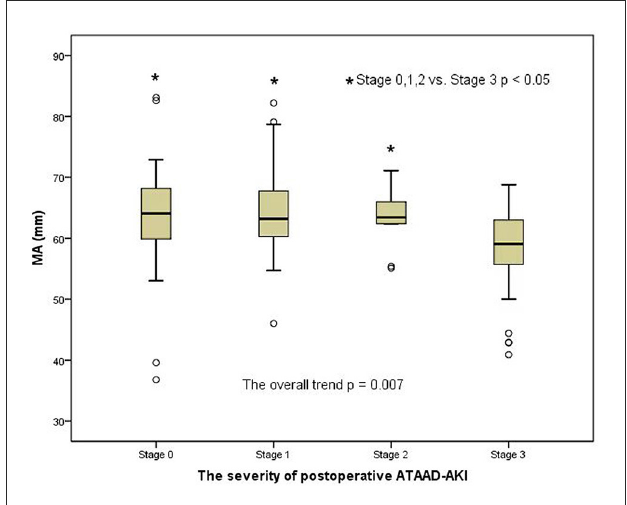
FIGURE2 Changes in preoperative MA level (platelet function) among the AKI